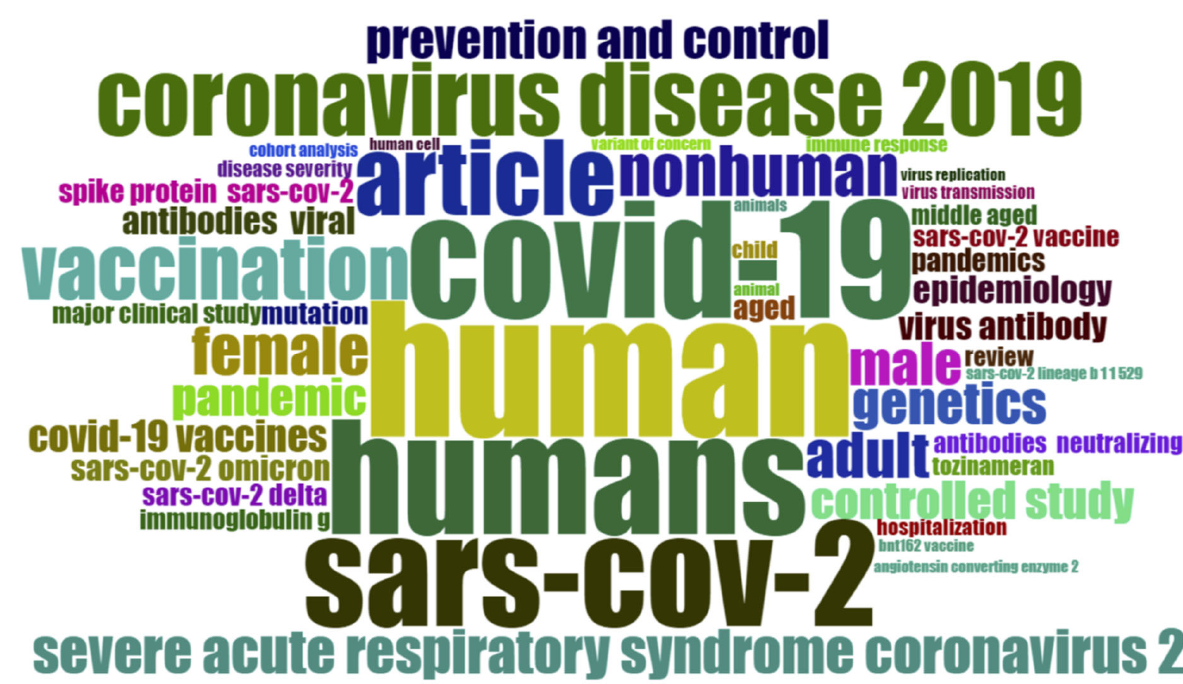
Figure 10. Word cloud of the most frequently used keywords in Omicron-variant-based research.